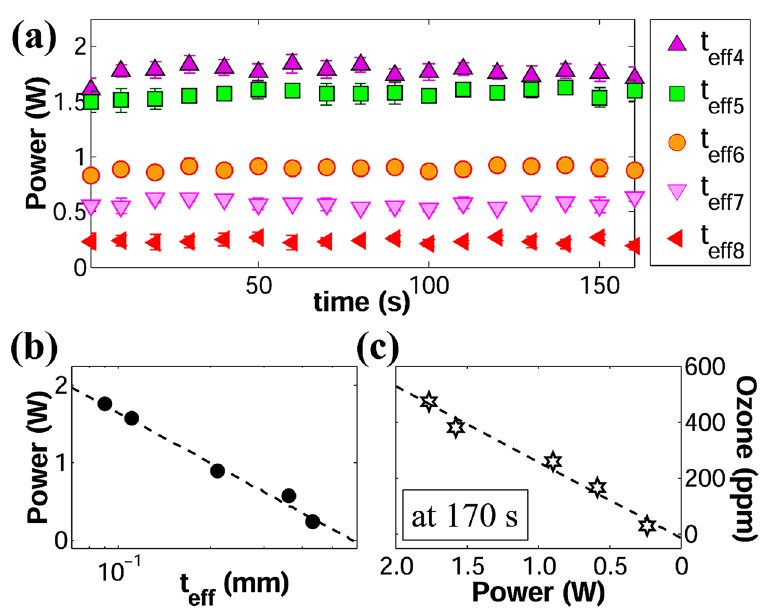
Figure 7. Power consumption of DBD-plasma reactors at 7 kVpp/10 kHz. ( a ) Instant power corresponding to different values of t eff . ( b ) Average power vs. t eff . ( c ) Ozone levels vs. average power at 170